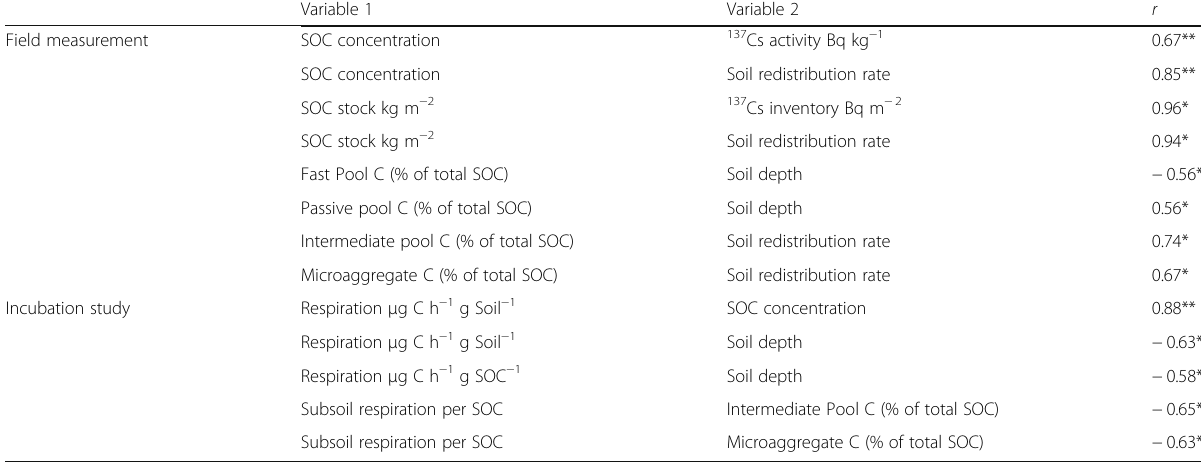
Table 1 Significant correlations. Pearson correlation coefficients of linear regressions ( r ) between the soil depth, soil redistribution rate, and SOC parameters. Single and double asterisks indicate the significance levels at p < 0.05 and p < 0.01, respectively